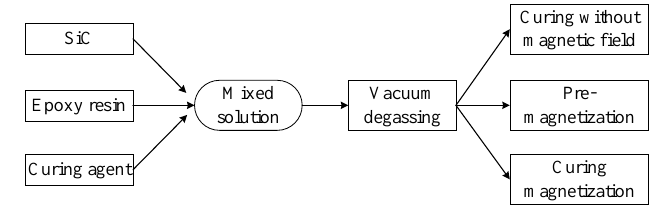
Figure 4. Preparation process of SiC/epoxy